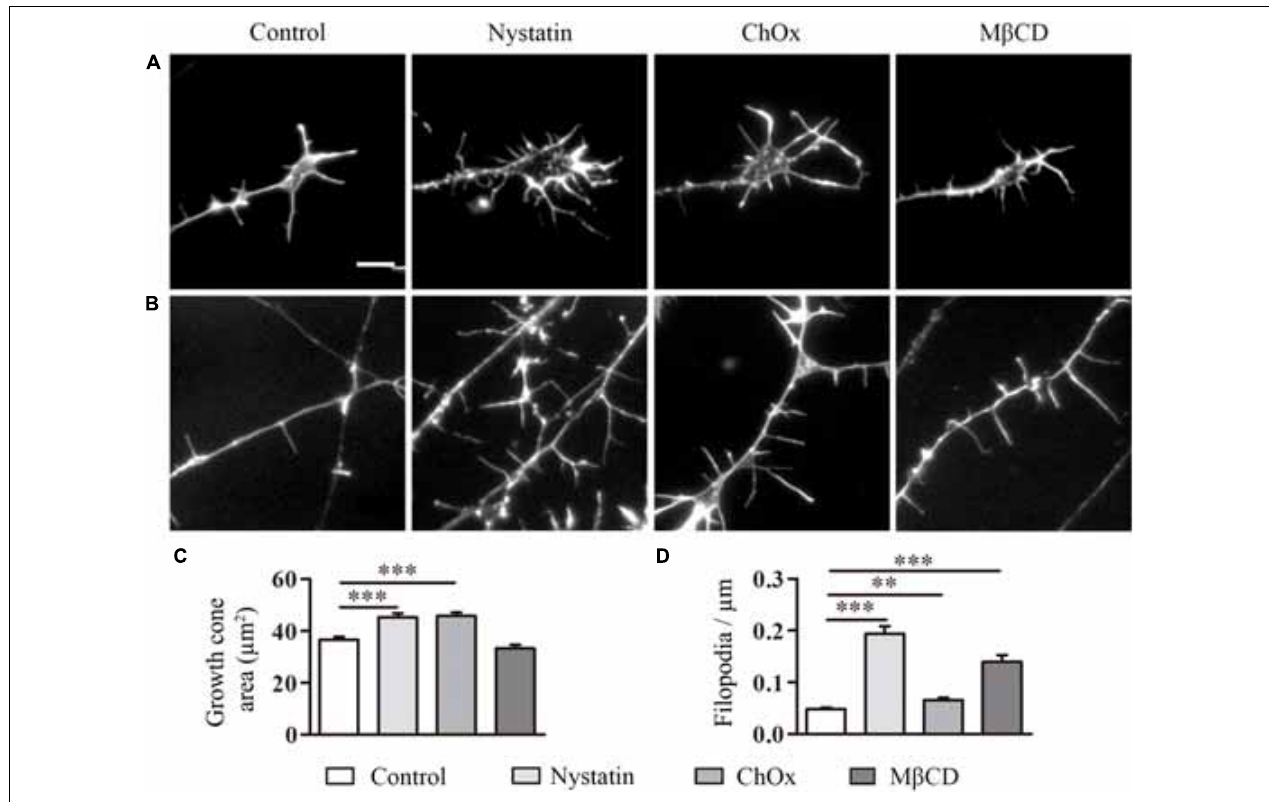
FIGURE 3 | Cholesterol depletion affects growth cone area and the density of filopodia in DRG neurons. Examples of DRG growth cones (A) and filopodia (B) incubated with control media, 2.5 µ g/ml Nystatin, 2U ChOx, and 0.5 mM M β CD and stained with phalloidin. Growth cone areas and filopodia from three independent experiments were measured. Data represent means ± SEM (C,D) . N = 150–250 neurons in each condition (One-way ANOVA, Dunnett’s Multiple comparison test ∗∗ p < 0.01, ∗∗∗ p < 0.0001). Scale bar 5 µ